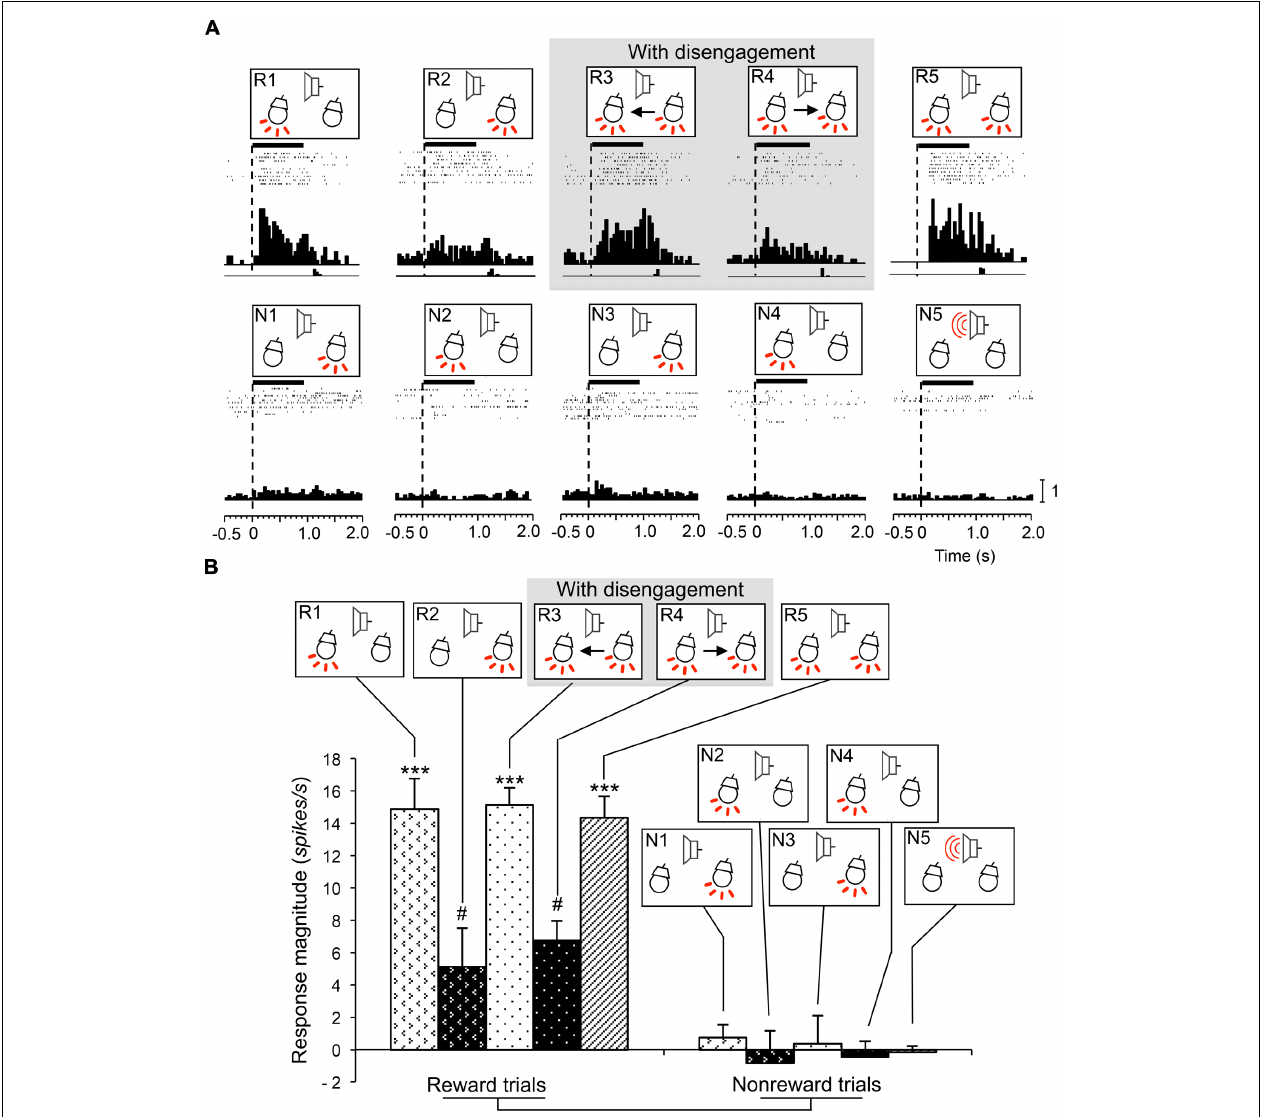
response magnitudes of the neuron shown in A to the CSs. ***significantly different from the CSs the CSs in N1 to N5 (Tukey test, P < 0.001); # significantly different from the CSs in R1, R3, and R5 (Tukey test, P < 0.05). Other descriptions are the same as